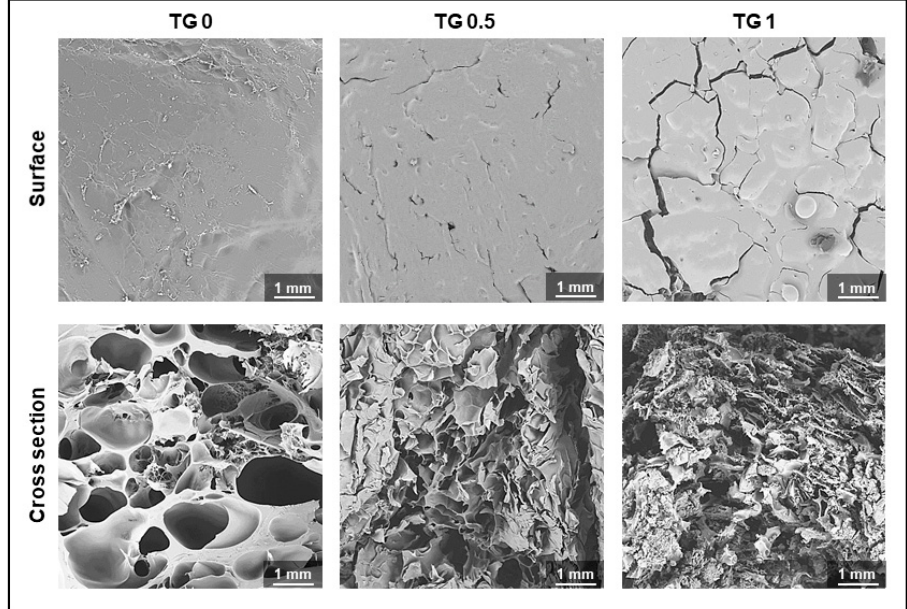
Figure 4. Electronic microscopic photos showing degree of crosslink of hydrogel with 3 different concentrations of transglutaminase (TGase) added. The surface becomes rougher and the cross section showed denser linkage as TGase concentration increase.